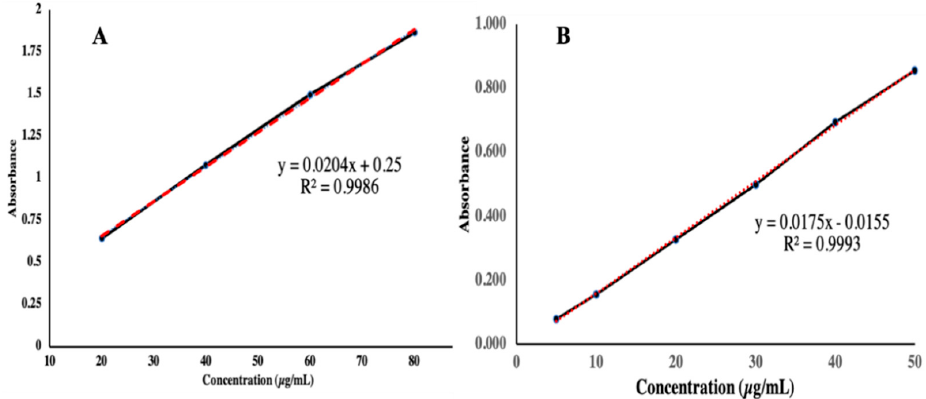
Figure 4. Calibration curve of TAF in ( A ) distilled water and ( B ) PBS buffer solution.